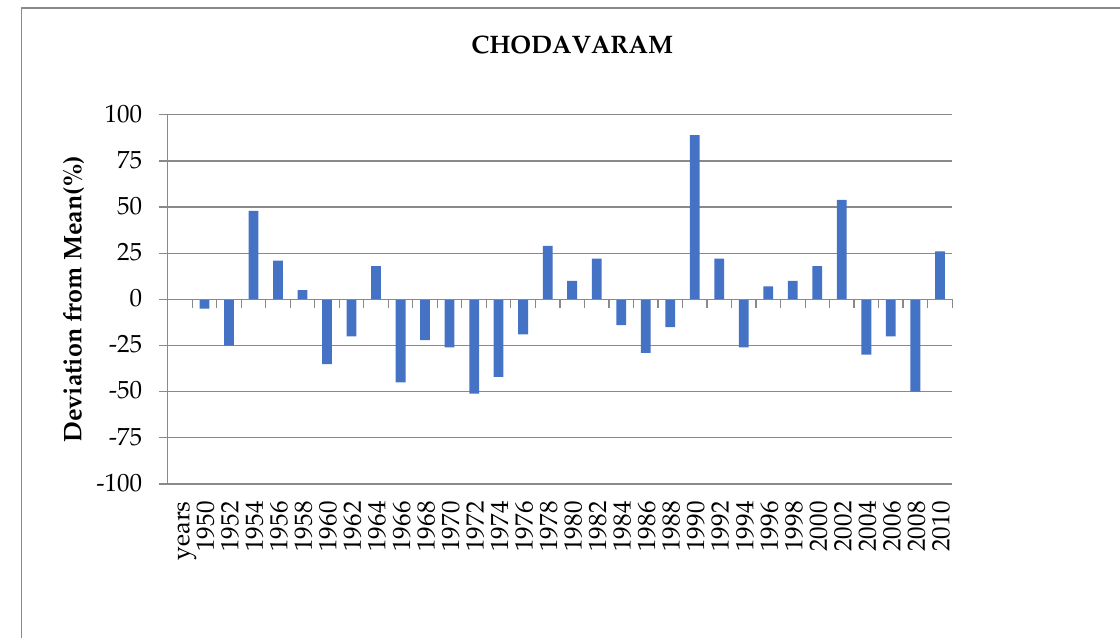
Figure 12. Chodavaram. Figure 12.